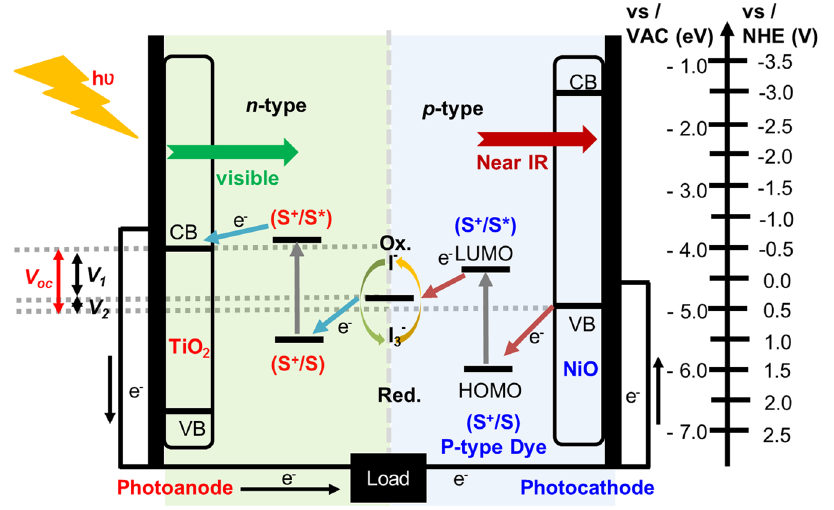
Figure 1. Schematic representation of tandem